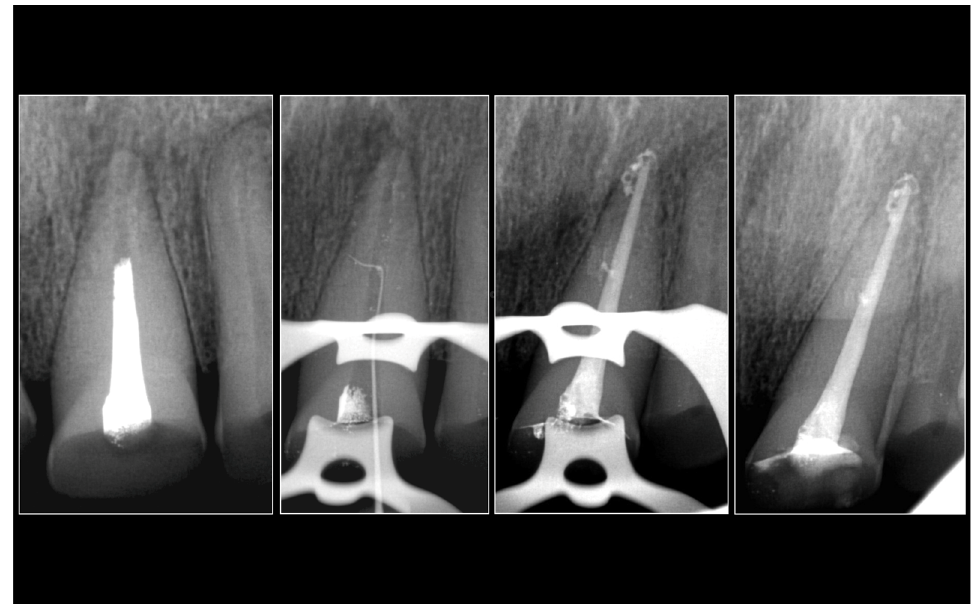
Figure 1. Non-surgical endodontic retreatment of tooth number 2.1. A complex endodontic space can be seen.